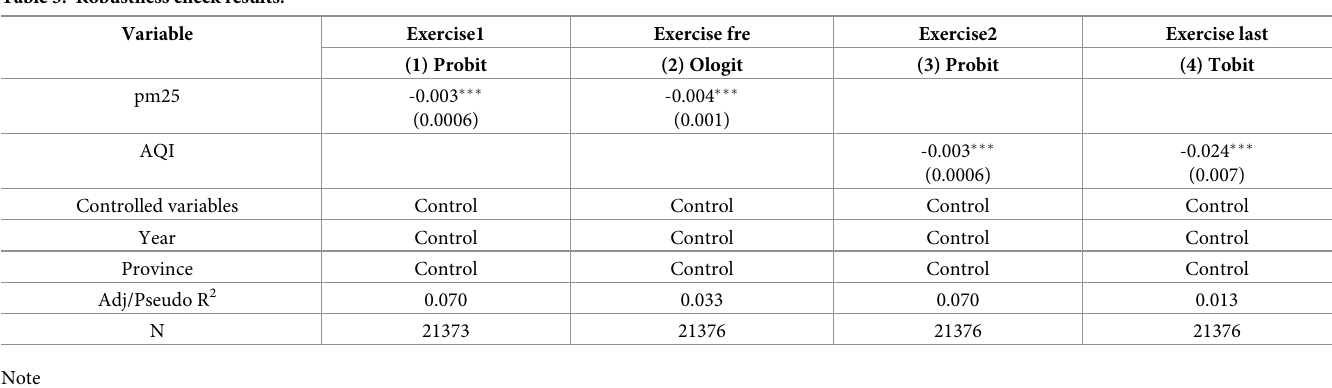
Table 5. Robustness check